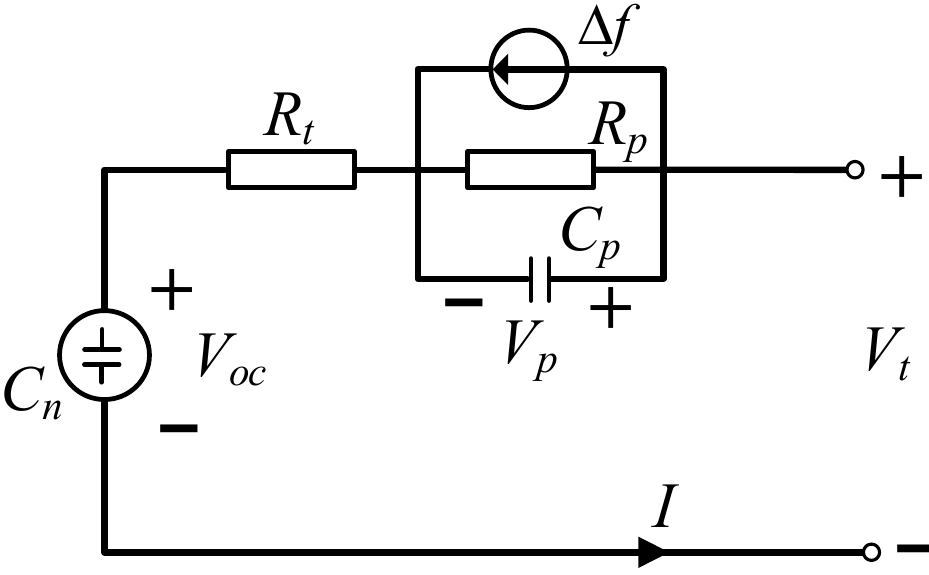
Figure 1. RC equivalent circuit model of the lithium battery.